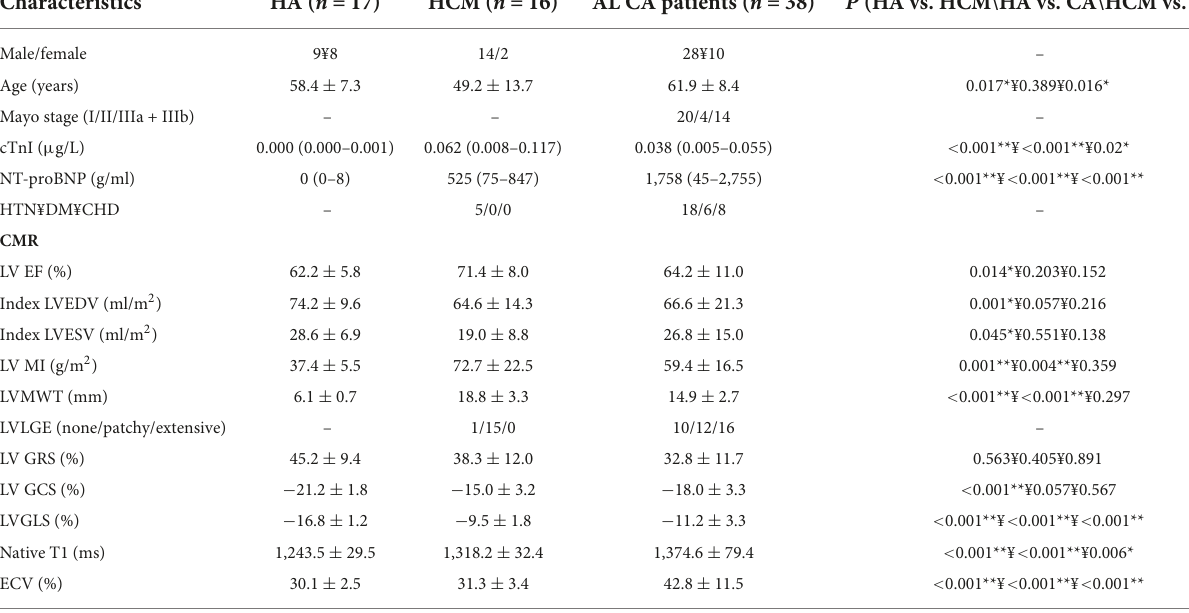
TABLE 1 Baseline characteristics of the healthy control, HCM patients, and AL CA patients. Characteristics